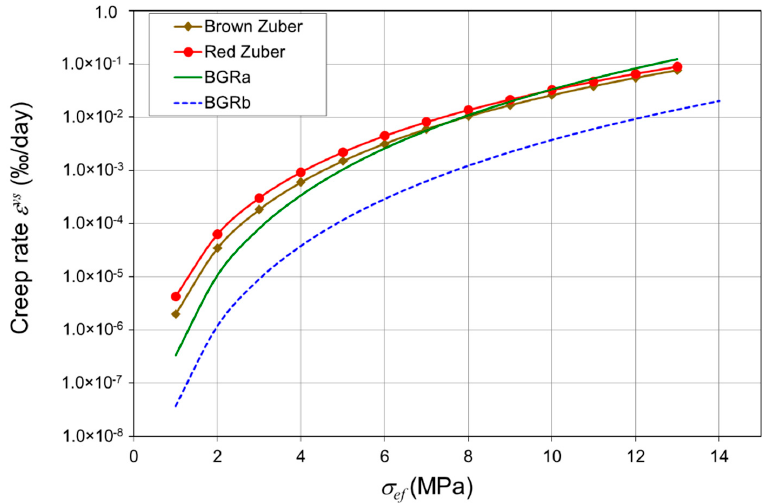
Figure 22. Creep rates of the Brown and Red Zuber unit samples and of the fast-creeping (BGRa) and slow-creeping (BGRb) rock salt samples in the effective stress function at a temperature of 50